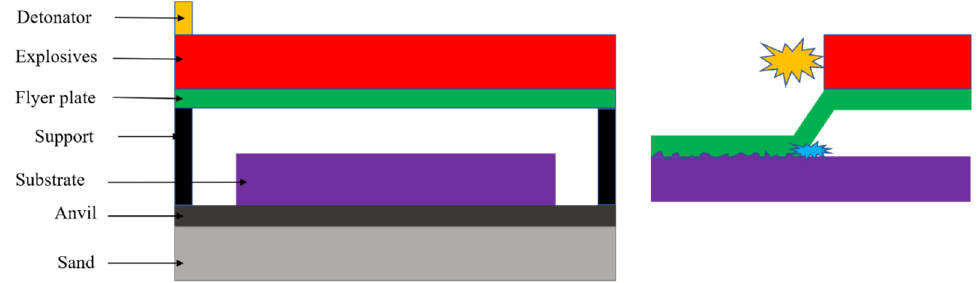
Figure 15. Schematic of the EW technique.